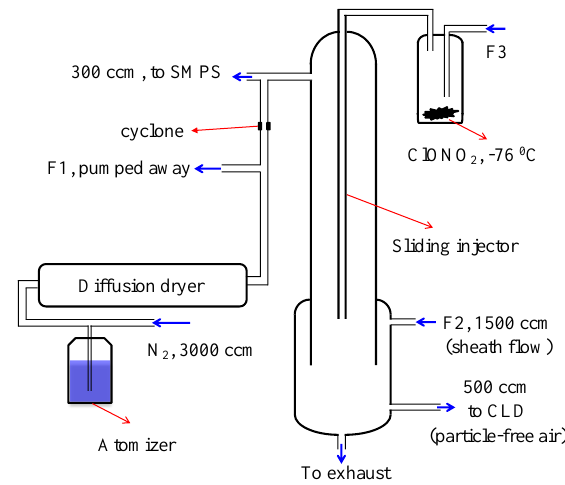
Figure 1. Schematic diagram of the aerosol flow tube used in this study. SMPS: scanning mobility particle sizer; CLD: chemilumines- cence detector, used to measure the ClONO 2 concentration (mea- sured as the change in NO concentration). All the flows (except the flow applied to the atomiser) were controlled by mass flow con- trollers. Flow details are provided in the